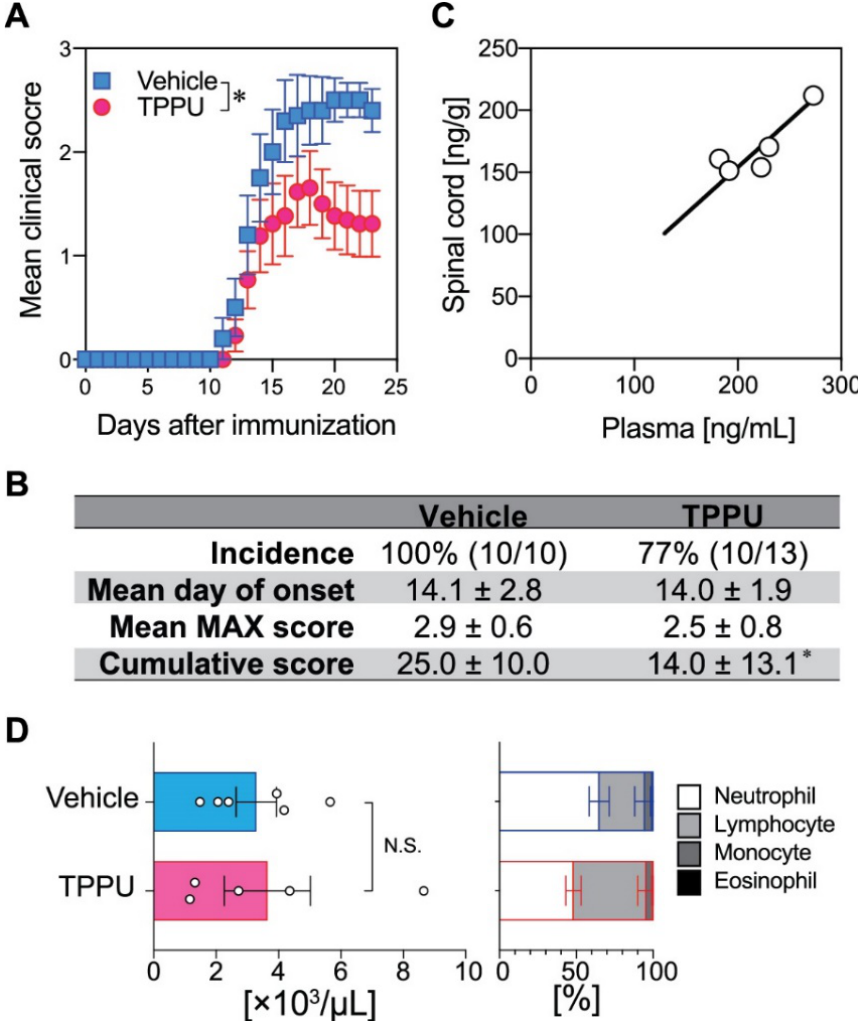
Figure 1. Effect of TPPU on EAE disease course and WBC counts. ( A ) Clinical course of TPPU-treated vs. vehicle-treated EAE mice. ( B ) Clinical parameters of TPPU-treated vs. vehicle-treated EAE mice. Mean MAX score is average of the maximal scores of the mice in each group. ( C ) TPPU concentration in EAE spinal cords and plasma. R 2 = 0.9708. P = 0.0003 was determined by Pearson correlation. ( D ) White blood cell counts and cellular populations in TPPU-treated vs. vehicle-treated EAE mice. P values were determined by two-way ANOVA or t-test. N.S., non-significant.